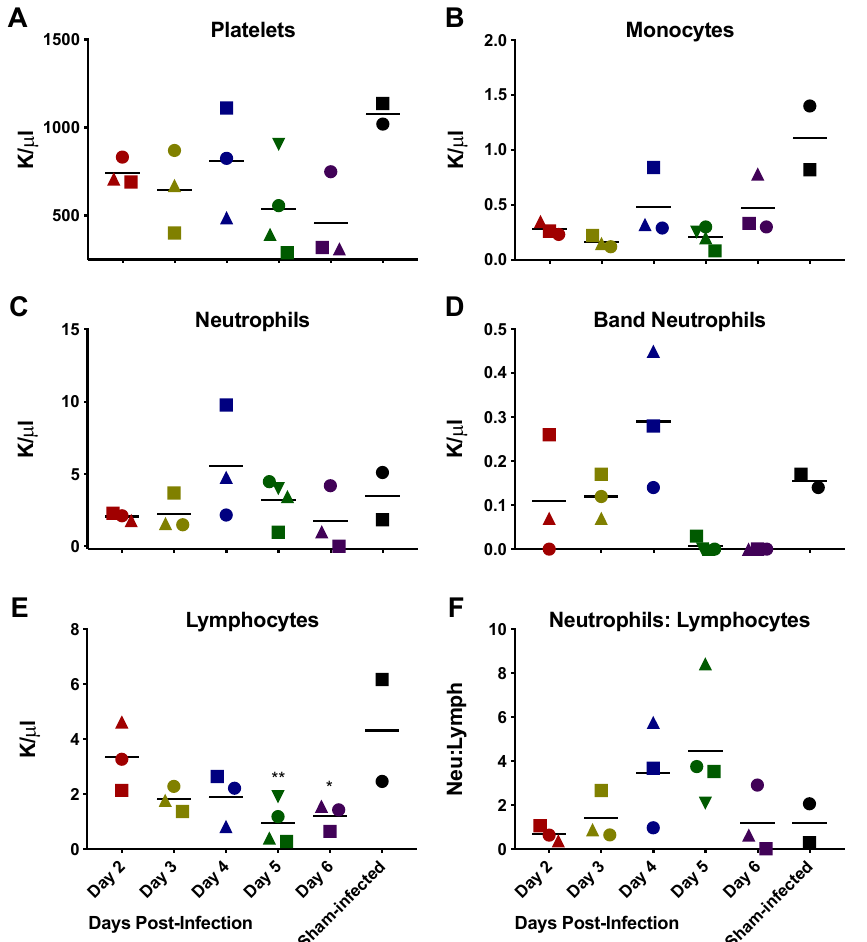
Figure 4. Alterations in lymphocyte and platelet parameters indicate inflammation during RVFV MP-12 infection in STAT2 KO hamsters. Changes in ( A ) platelets; ( B ) monocytes; ( C ) neutrophils; ( D ) band (immature) neutrophils; ( E ) lymphocytes and ( F ) ratio of neutrophils to lymphocytes are shown. One hamster in the day 6 group succumbed to infection prior to sacrifice and therefore could not be included in the analysis. Unique symbols at each sacrifice day represent values for the same animal across all parameters. * p < 0.05 and ** p < 0.01 compared to day 2 RVFV-MP-12-infected animals. The complete set of hematologic parameters assessed are summarized in Supplementary Table S2.